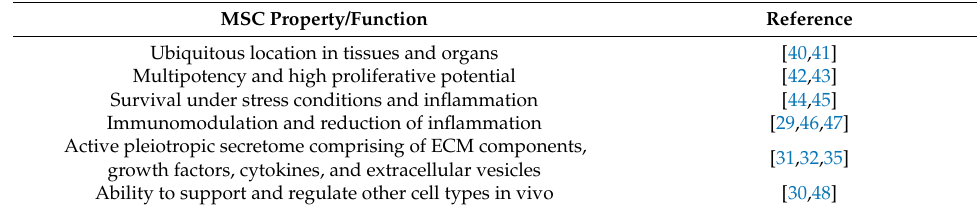
Table 1. Biological properties of mesenchymal stromal cells (MSCs) that contribute to their potential as participants of feeder